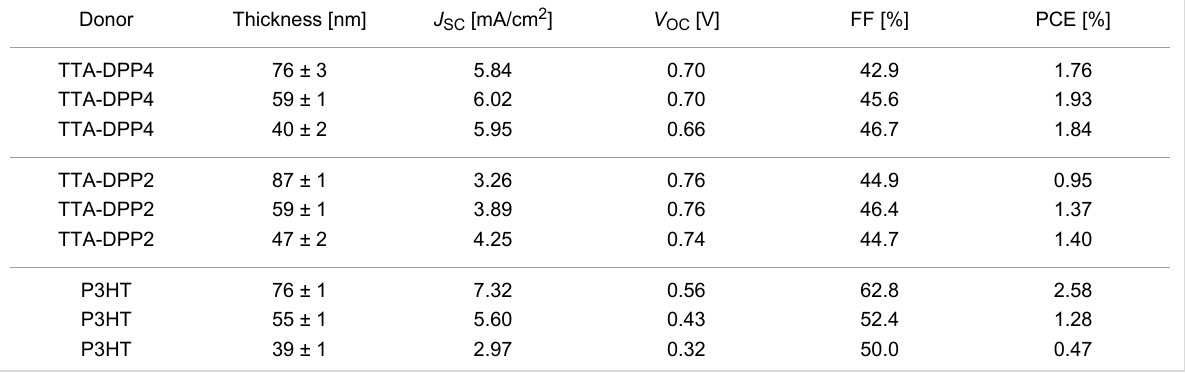
Table 2: Photovoltaic parameters for inverted BHJ-OSCs based on TTA-DPP4 or TTA-DPP2:PC 71 BM and P3HT:PC 61 BM under simulated AM 1.5 G, 100 mW cm − 1 illumination.